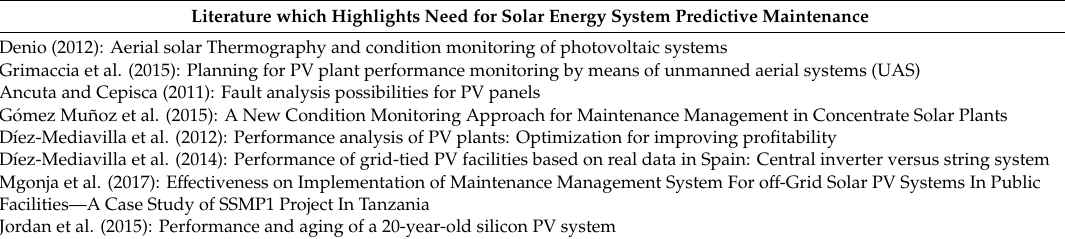
Table 1. Summary of the literature (need for predictive